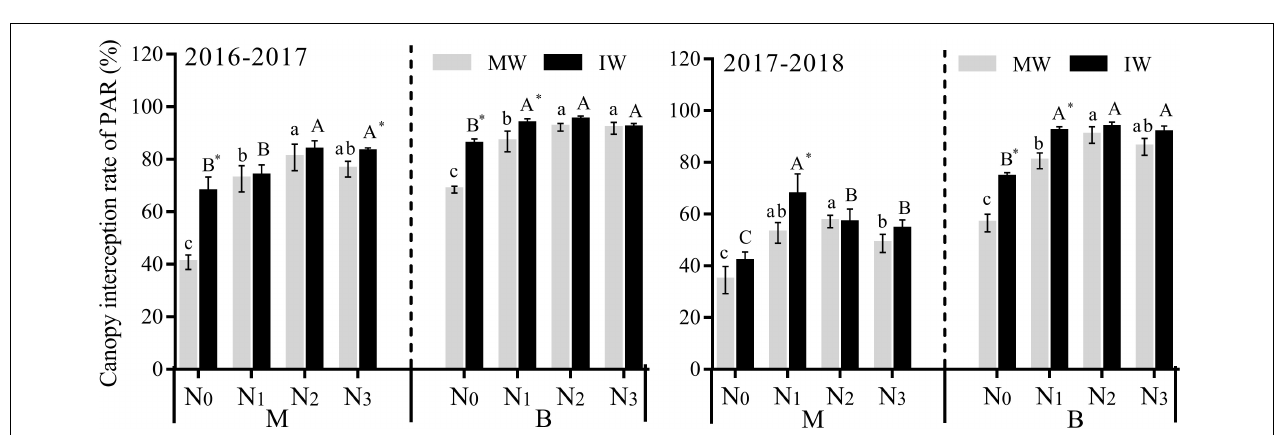
FIGURE 3 | Effects of applied nitrogen and intercropping on photosynthetically active radiation transmittance (PART) in the wheat canopy. MW, monocropped wheat; IW, intercropped wheat; M, middle of canopy; B, below of canopy. The different capital letters and small letters represent significant differences between different N levels in the same planting pattern at P < 0.05 levels. * Represents significant difference between monocropped and intercropped patterns at the same N level ( P < 0.05).